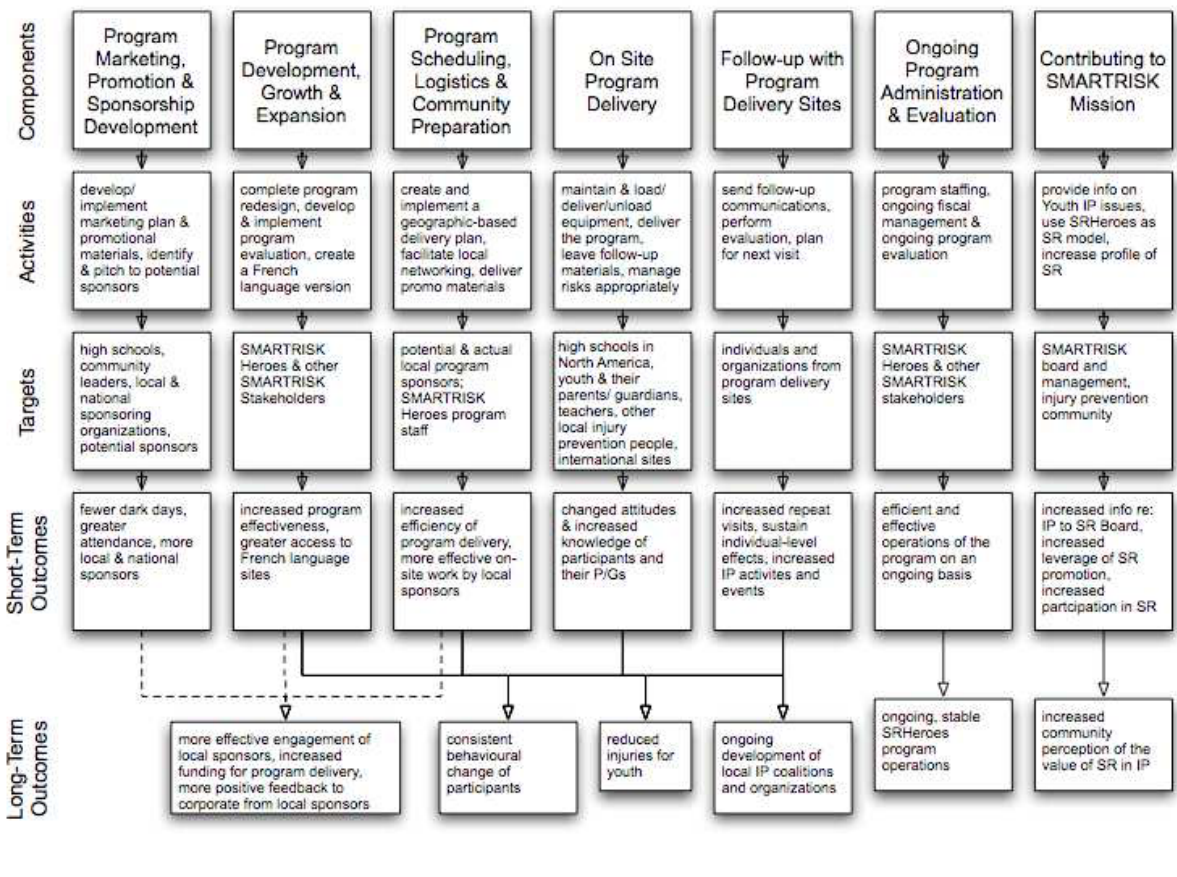
SMARTRISK Heroes Program Logic